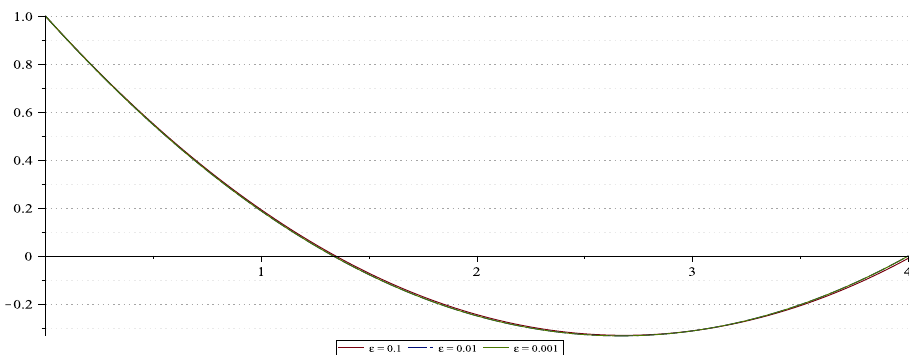
Figure 5. The relative lateral velocity z 2 ( t ) for varying ε .